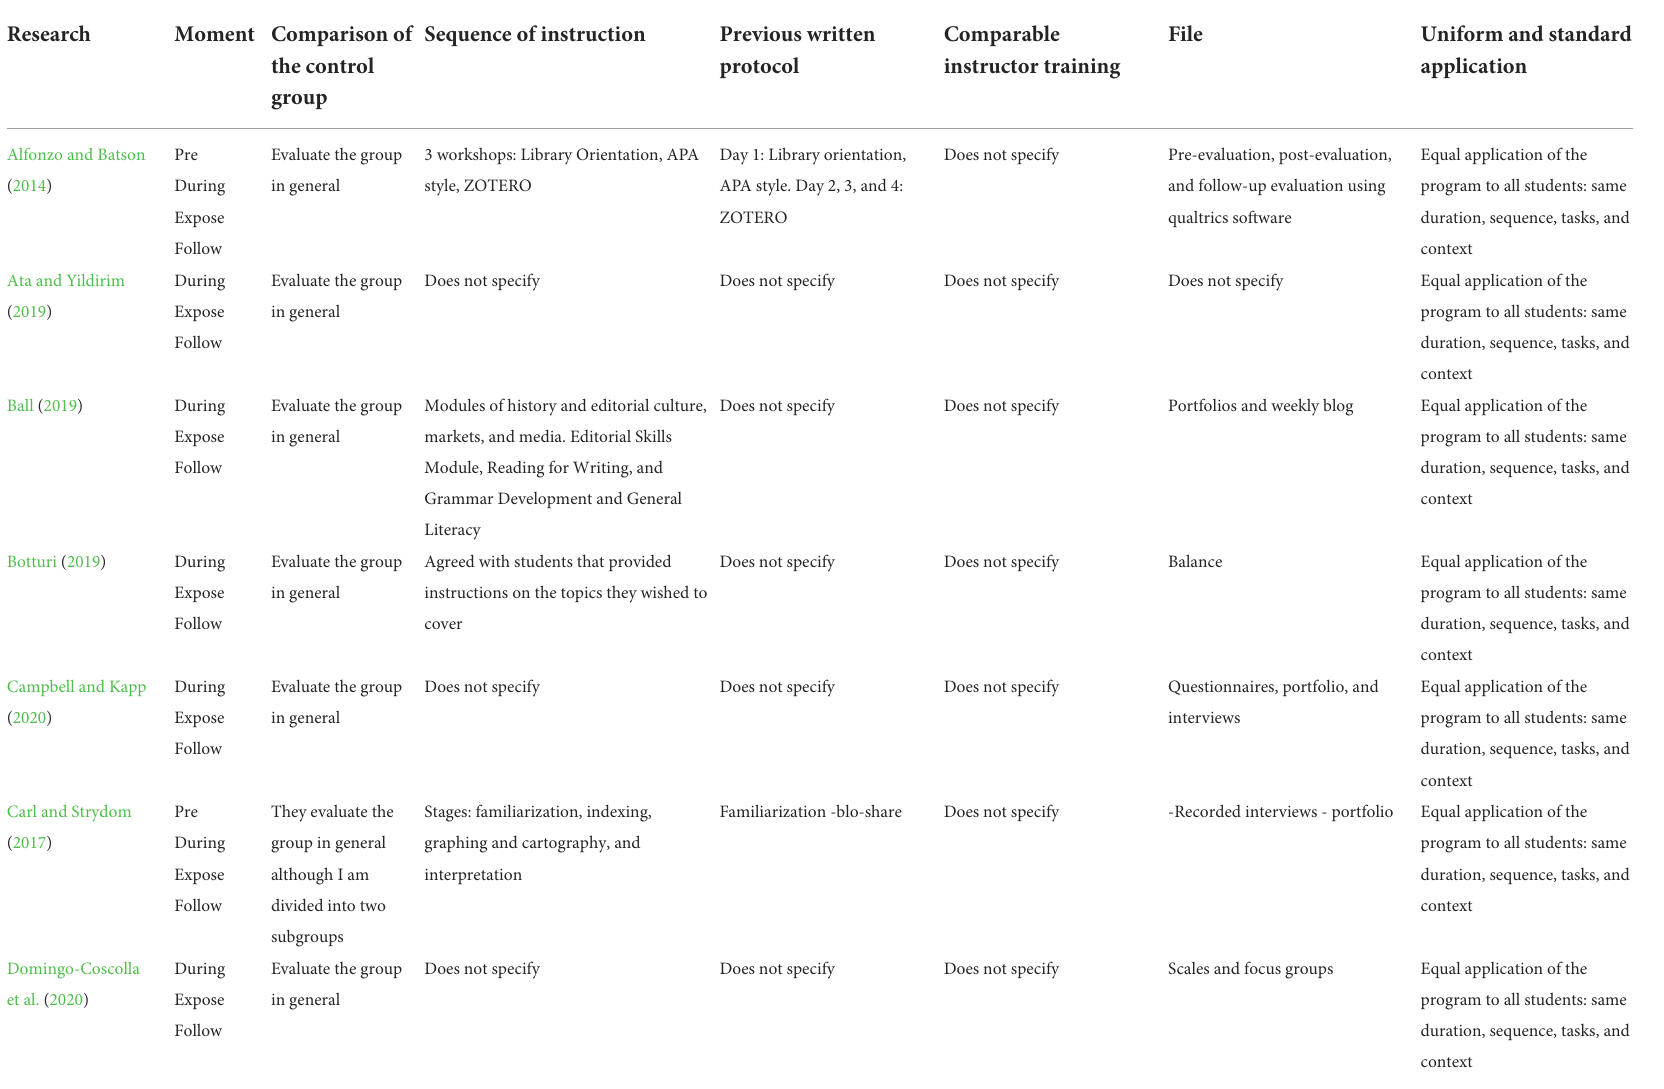
TABLE 7 Treatment